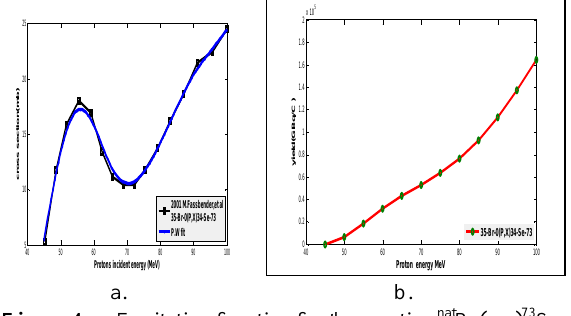
Figure 4: a. Excitation function for the reaction nat Br(p,x) 73 Se. b. Isotopes production yield for the reaction nat Br(p,x) 73 Se. Figure 5 : a.Excitation function for production 73 Se for reactions 74 Se, nat Se , nat Br(p,x) 73 Se and 75 As(p,x) 73 Se. b. Isotopes production yield for the reactions 74 Se, nat Se , nat Br (p,x) 73 Se and 75 As(p,3n) 73 Se.